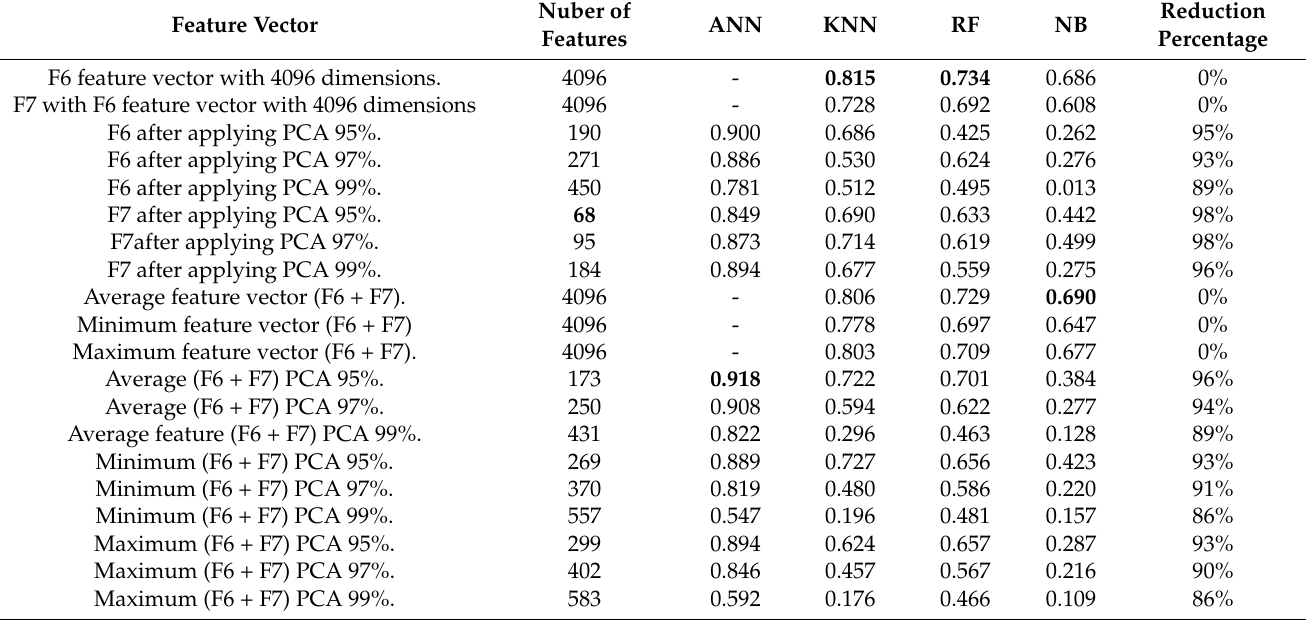
Table 13. Identification accuracy results summery. Bold values signify the best performance. Feature Vector